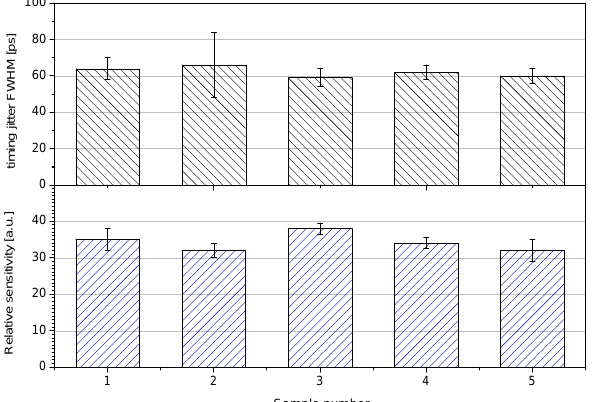
Figure 10. Timing resolution and sensitivity of reference (not irradiated samples) 1, 4, 5 and 100 krad irradiated samples 2, 3. The irradiated samples does not exhibit any measurable parameter